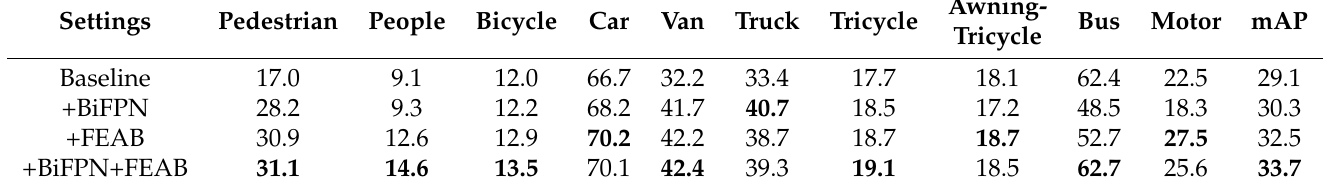
Table 4. Ablation studies of two key components of the Visdrone dataset. The bolded numbers are the best indicators for each category.